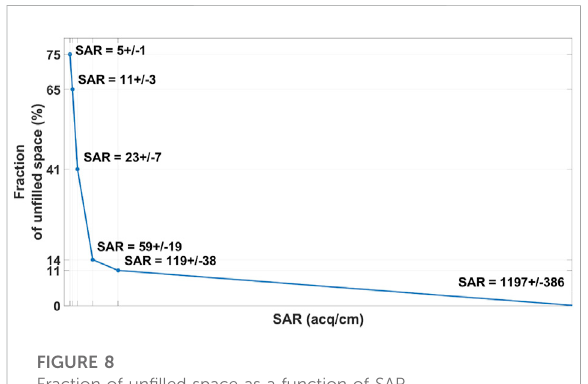
FIGURE 8 Fraction of un fi lled space as a function of